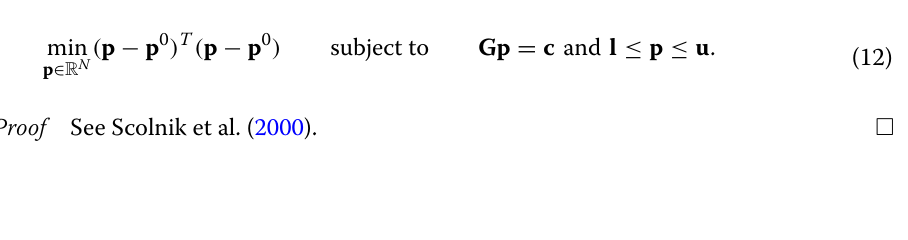
subject to Gp = c and l ≤ p ≤ u